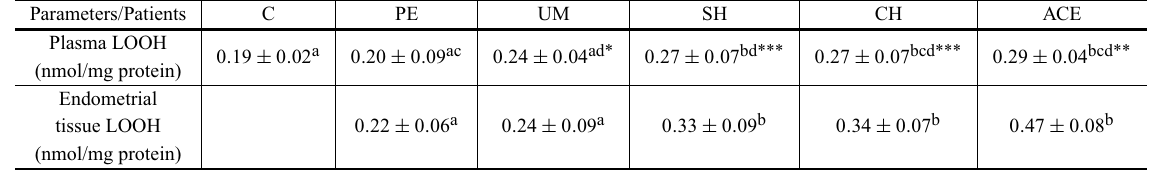
LOOH concentration in plasma and endometrial tissue of control patients (C) and patients diagnosed with: polypus endometrii (PE), uterus myomatosus (UM), simple hyperplasia (SH), complex hyperplasia (CH) and adenocarcinoma endometrii (ACE), (mean ± SD).